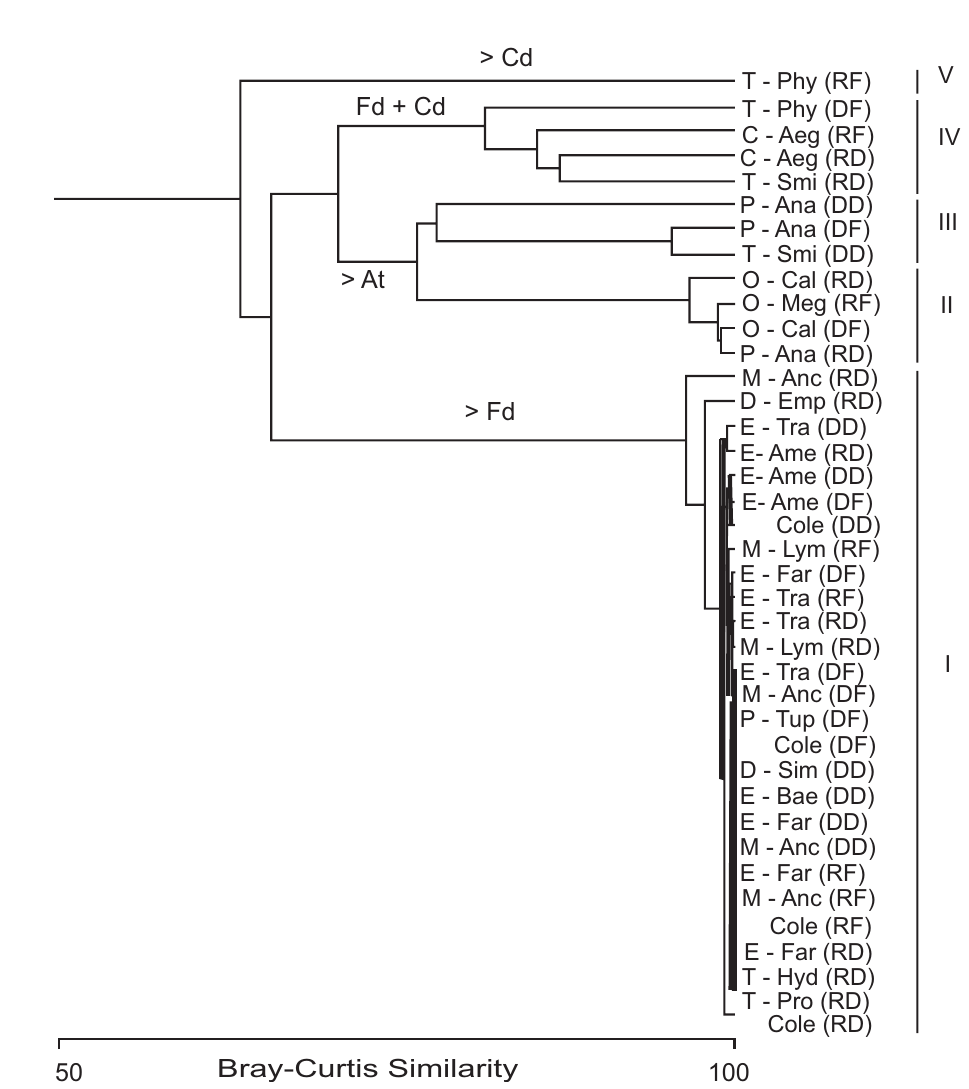
Figure 5. Dendrogram of similarity grouping 39 macroinvertebrates taxa based on diet data. Taxa that consumed mainly coarse detritus (>Cd), fine and coarse detritus (Fd + Cd), mainly animal tissue (>At), and mainly fine detritus (>Fd). (C-Aeg) Crustacea- Aegla castro , (Cole) Coleoptera- Heterelmis , (D-Emp) Diptera-Empididae, (D-Sim) Diptera-Simuliidae, (E-Ame) Ephemeroptera- Americabaetis , (E-Bae) Ephemeroptera- Baetodes , (E-Far) Ephemeroptera- Farrodes , (E-Tra) Ephemeroptera- Traverhyphes , (M-Anc) Mollusca-Ancylidae, (M-Lym) Mollusca-Lymnaeidae, (O-Cal) Odonata- Hetaerina , (O-Meg) Odonata- Heteragrion , (P-Ana) Plecoptera- Anacroneuria , (P-Tup) Plecoptera- Tupiperla , (T-Hyd) Trichoptera- Hydroptila , (T-Phy) Trichoptera- Phylloicus , (T-Pro) Trichoptera- Protoptila , (T-Smi) Trichoptera- Smicridea , (RF) rainy season-forested area, (RD) rainy season-deforested area, (DF) dry season-forested area, (DD) dry season-deforested area. For explanation about the groups classification (I to V) sees the